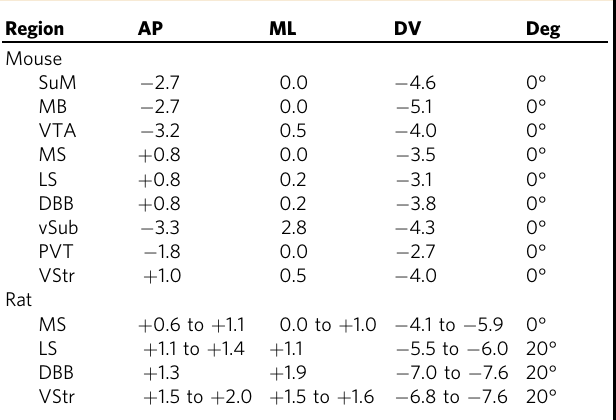
Table 2 Stereotaxic coordinates for injections and